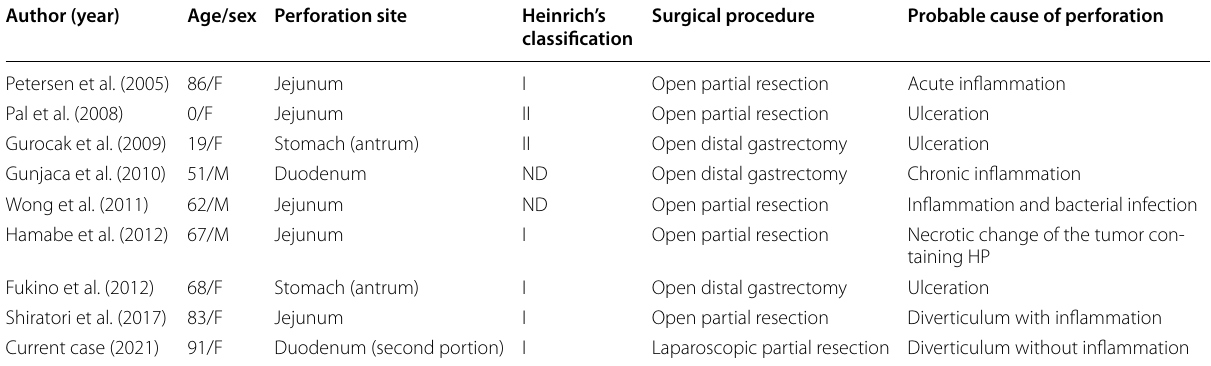
Table 1 Summary of the nine cases of gastrointestinal perforations related to HP